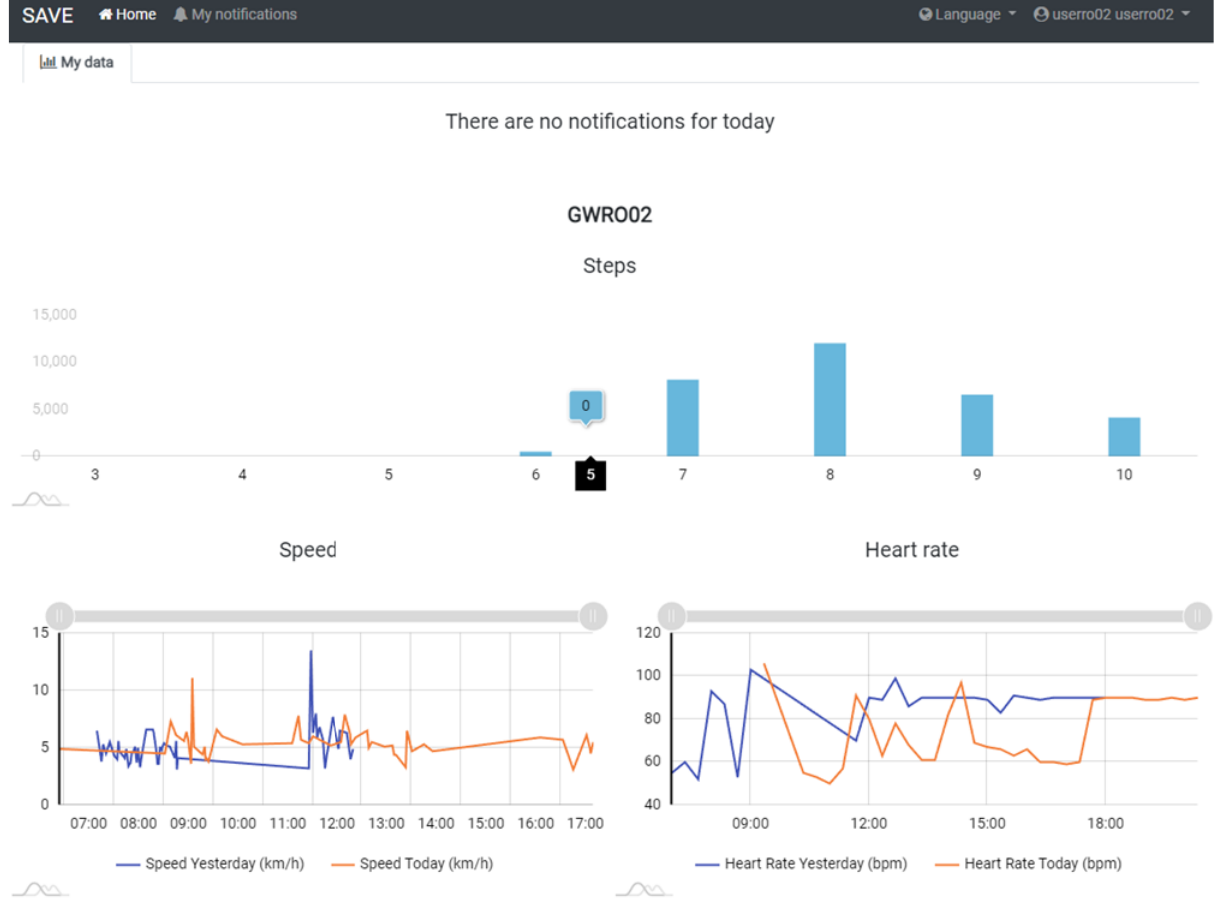
Figure 8. Samples of visualization of user data.